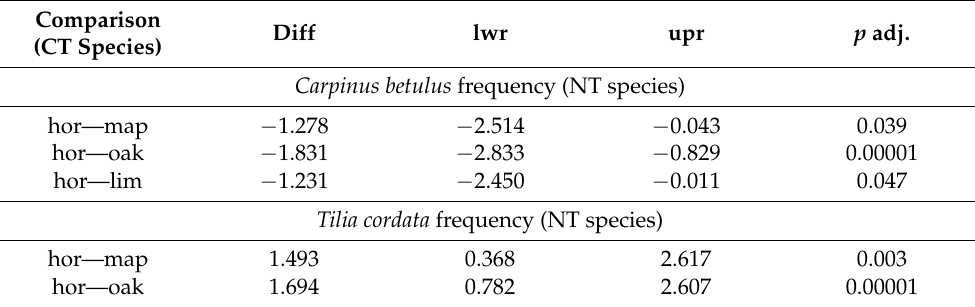
Figure 3. Frequency of the dominating neighbour tree (NT) species: Carpinus betulus , Tilia cordata and Picea abies around large central trees of Quercus robur , C. betulus , Acer platanoides , P. abies , and T. cordata . Table 3. Results of the HSD Tukey pairwise post-hoc test for frequencies of the dominant neighboring tree species ( Carpinus betulus and Tilia cordata ) in the clusters surrounding large old central trees. Only significant differences are considered for central trees of C. betulus (hor), Acer platanoides (map), Quercus robur (oak), and T. cordata (lim).